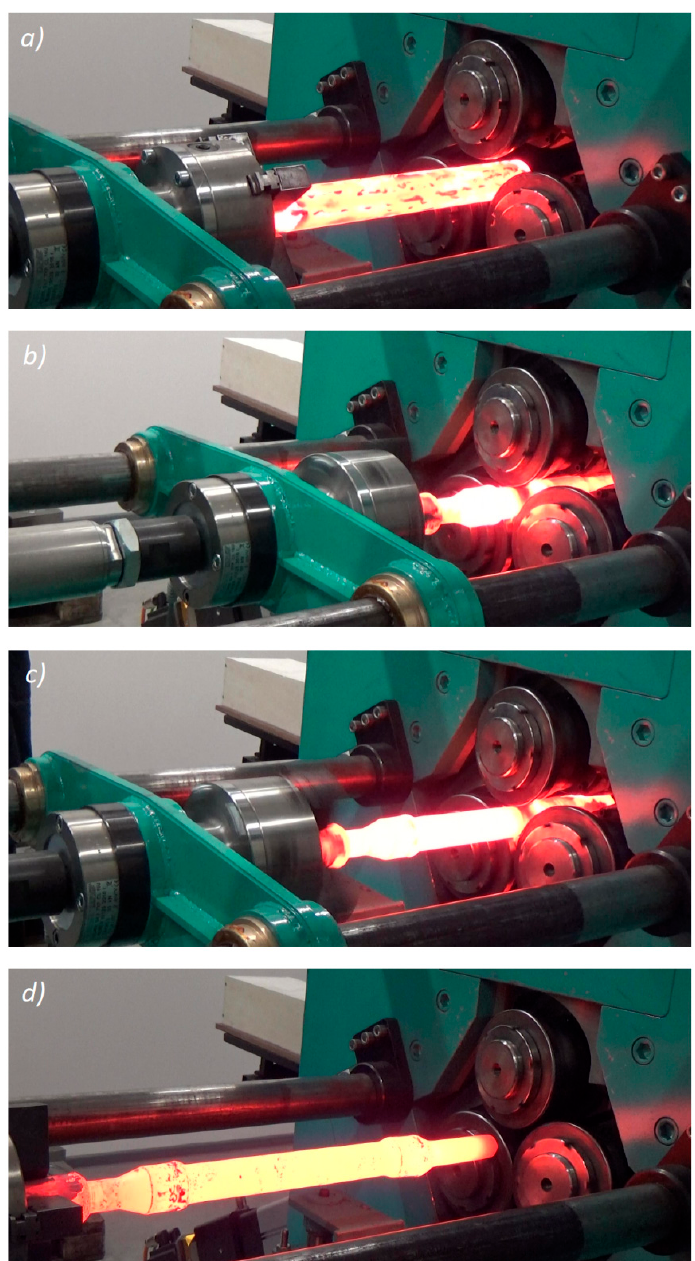
Figure 25. Skew rolling of a solid axle (in 1:5 scale) under laboratory conditions at the Lublin University of Technology: ( a ) billet is fed into the working space ( b ) beginning of the forming process, ( c ) end of the forming process, ( d ) rolled axle.